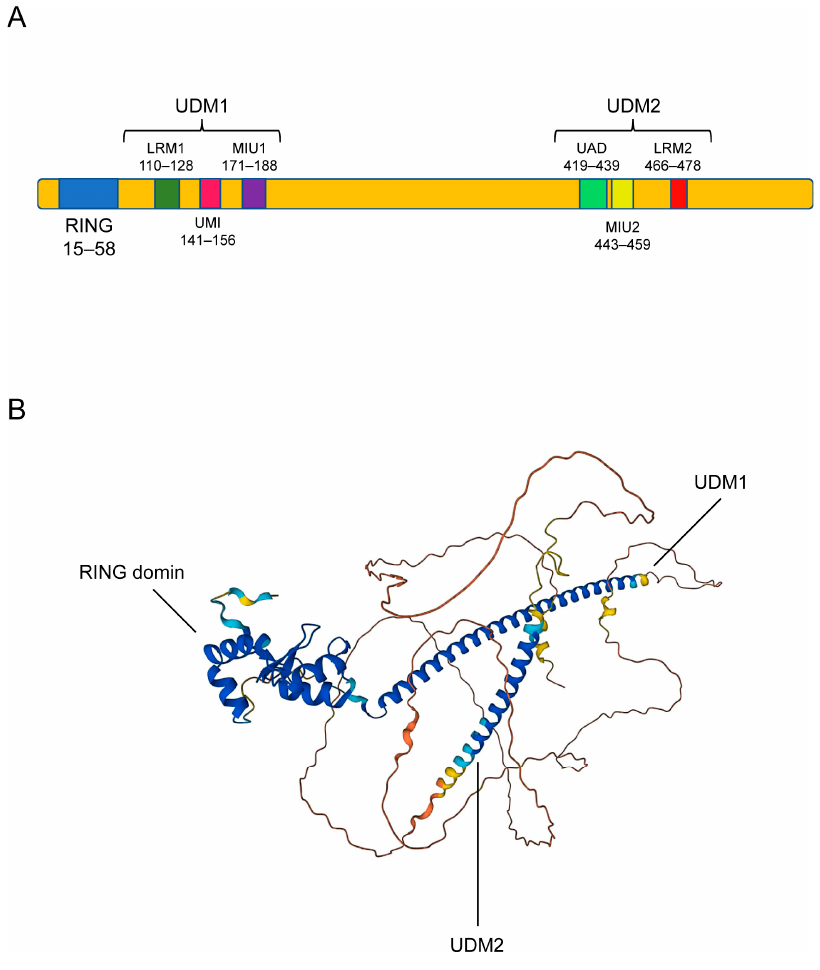
Figure 3. Structure of RNF168. ( A ) RNF168 is composed of a catalytic RING (15–58) domain and two ubiquitin-dependent DSB recruitment modules (UDMs). UDM1 is composed of LRM1 (110–128), UMI (141–156), and MIU1 (171–188), and UDM2 is composed by UAD (419–439), MIU2 (443–459), and LRM2 (466–478). ( B ) RNF168 has three domains, which are RING domain, UDM1 and UDM2 from left to right in the figure. AlphaFold produces a per-residue confidence score (pLDDT) between 0 and 100. Some regions below 50 pLDDT may be unstructured in isolation. Dark blue indicates pLDDT > 90, blue indicates 90 > pLDDT > 70, yellow indicates 70 > pLDDT > 50, and orange indicates pLDDT < 50.